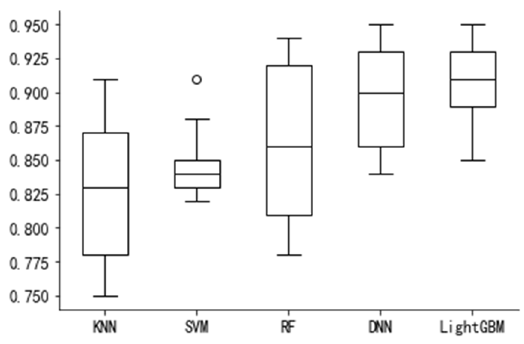
Figure 6. Comparison of model prediction accuracy.